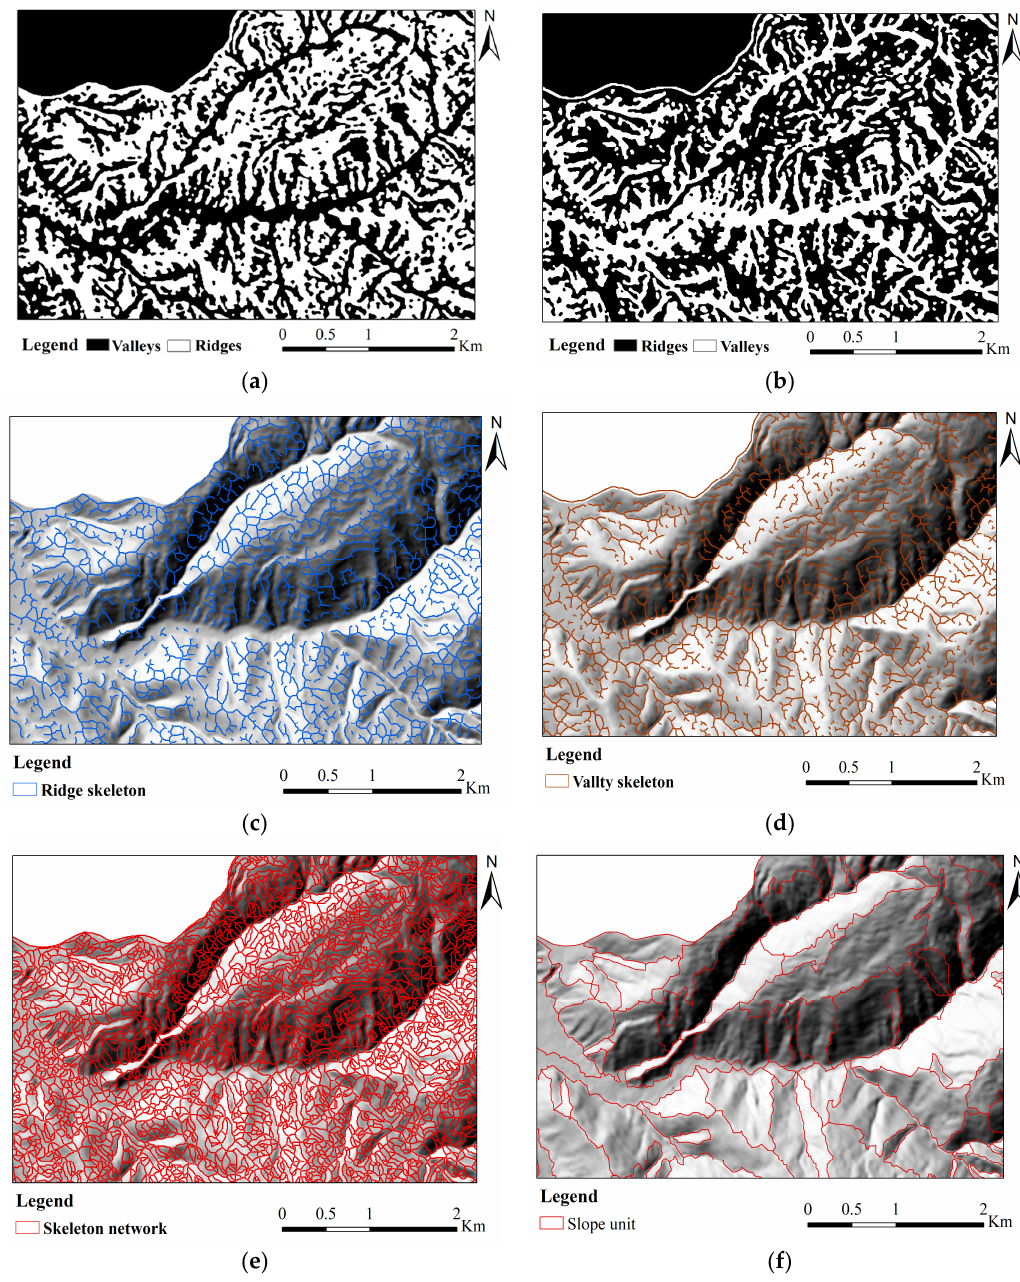
Figure 3. Morphological ridge and valley skeletons showing ( a ) binary image with valleys shown in white, ( b ) binary image with ridges shown in white, ( c ) morphological skeleton of valleys over shaded relief, ( d ) morphological skeleton of ridges over shaded relief, ( e ) closed morphological skeleton network in which each small region contains homogenous geomorphological features and ( f ) slope unit extracted by MIA-HSU method.